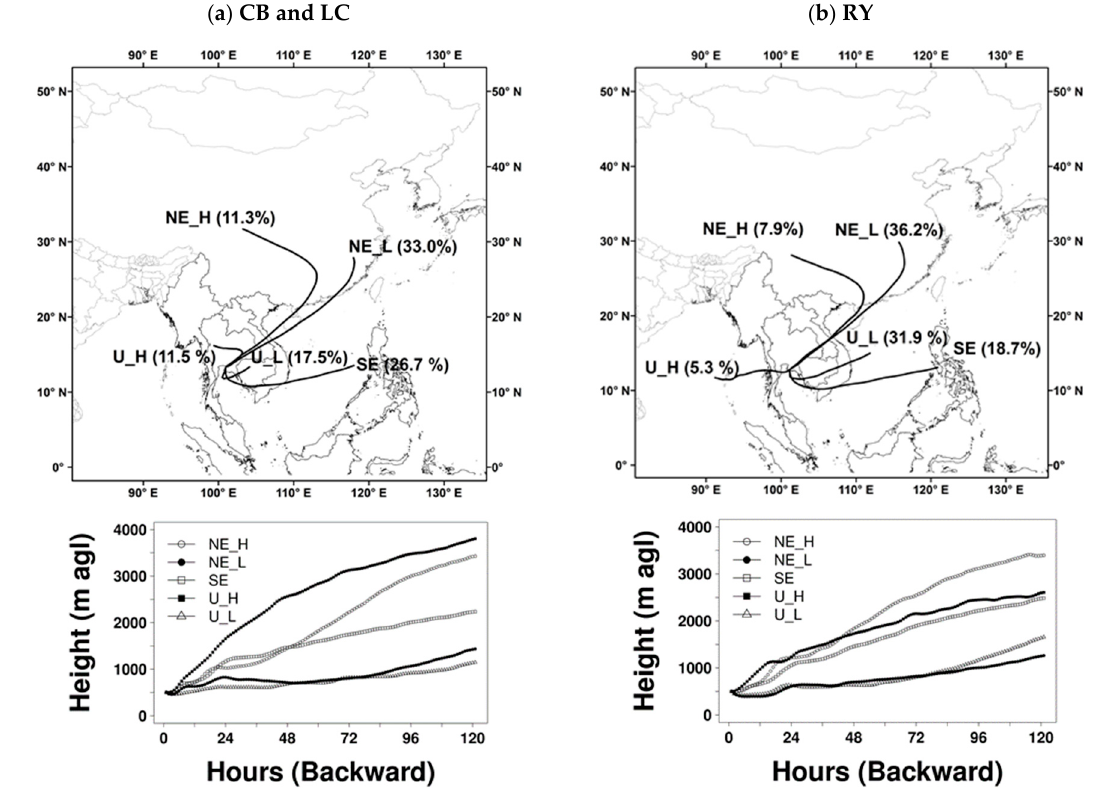
Figure 7. Average back-trajectory path and its average height by cluster at stations ( a ) CB and LC; and ( b ) RY. Table 2. Average visibility, RH , RH -corrected visibility, and PM 10 by back-trajectory cluster at stations CB, LC, and RY.